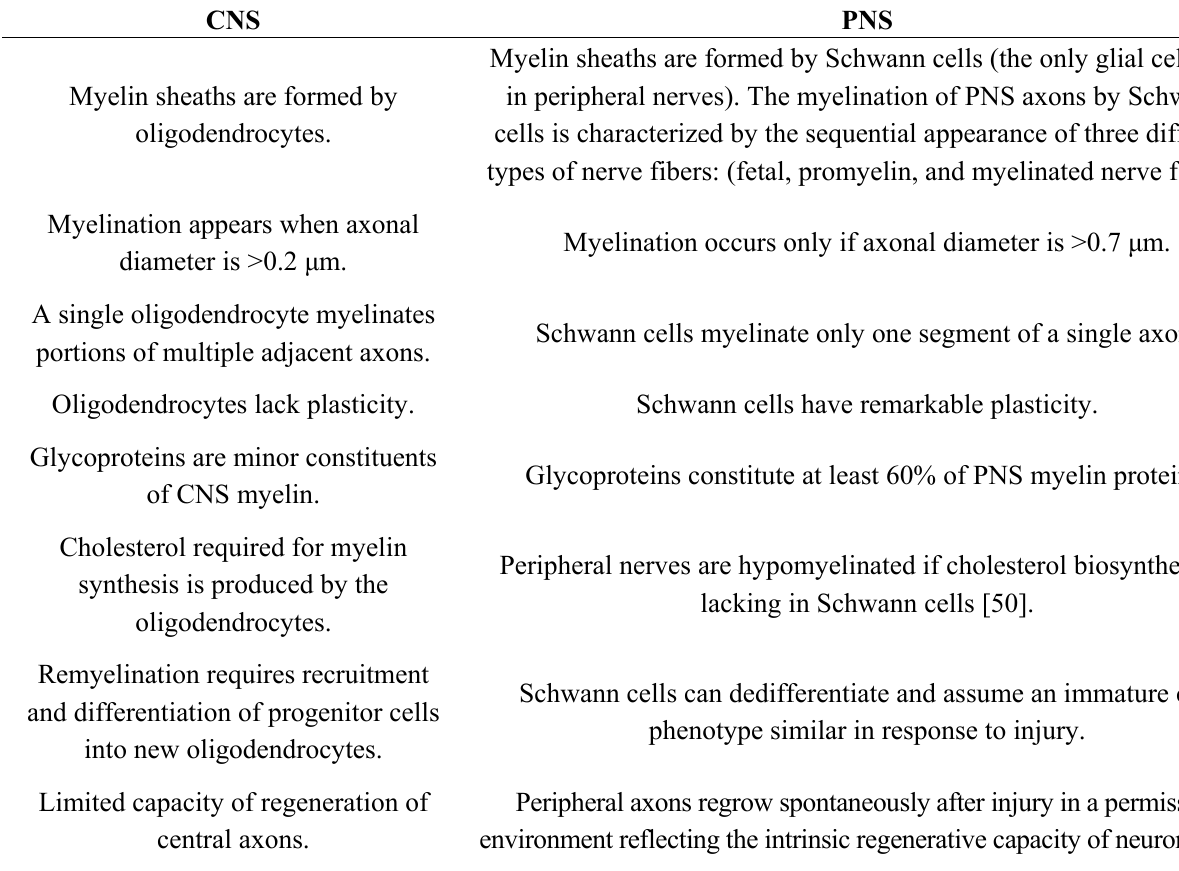
Table 1. Differences regarding myelination in CNS vs .